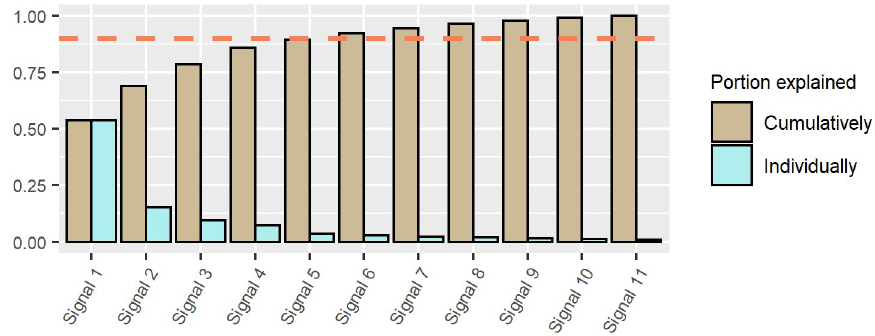
Fig 4. Plot of the individual and cumulative portions of variance explained by each signal in the financial dataset.